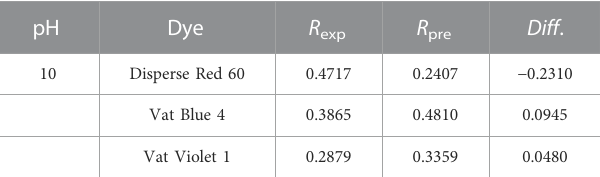
TABLE 6 Comparisons of experimental data and the predicted values of the optimal QSAR model. pH Dye R exp R pre Diff